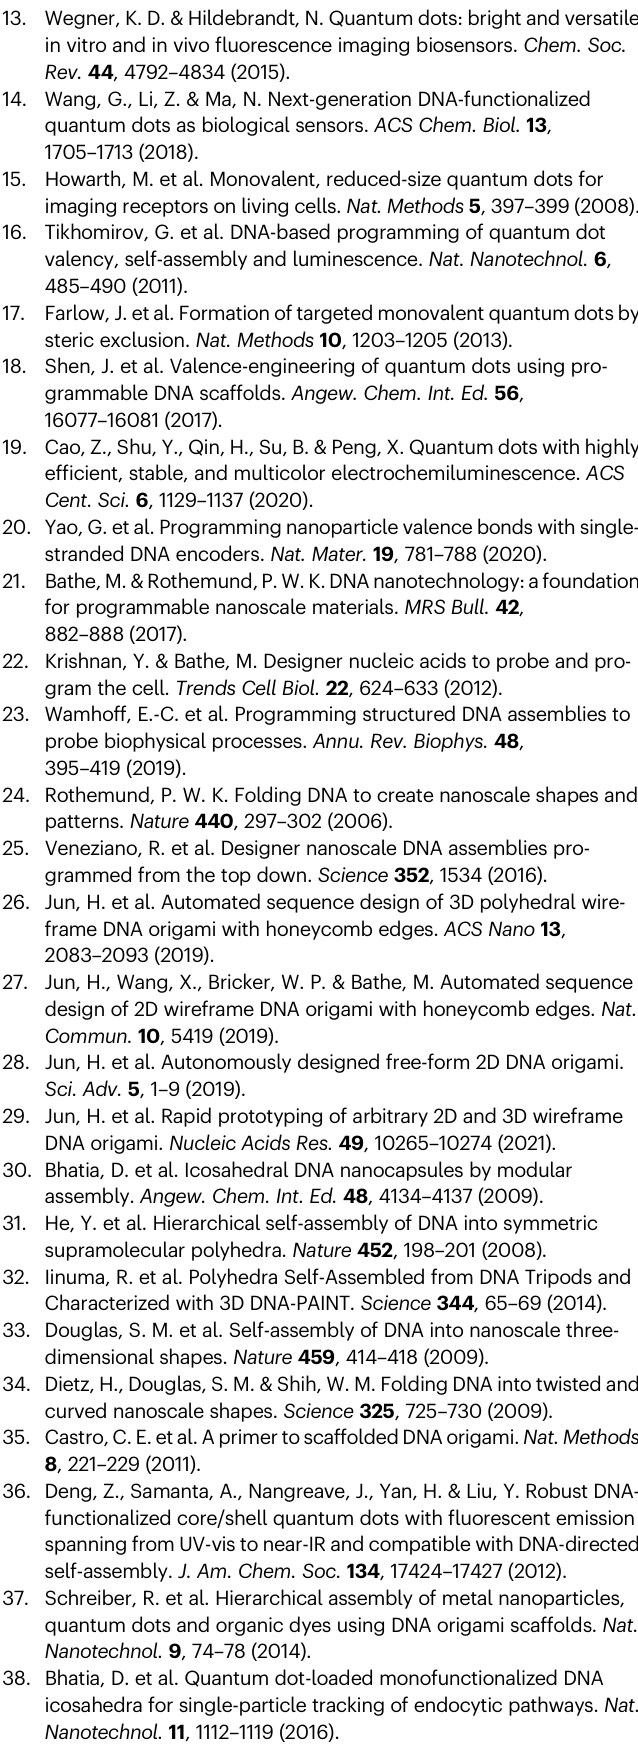
algorithm 75 . The force fi eld parameters are listed in Supplementary Tables 11 –